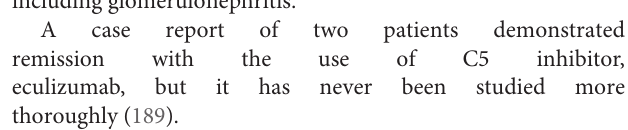
Frontiers in Medicine |